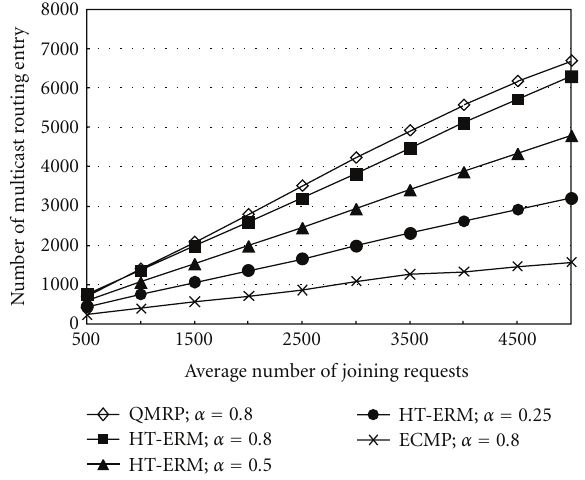
Figure 6: Comparisons of multicast forwarding entry